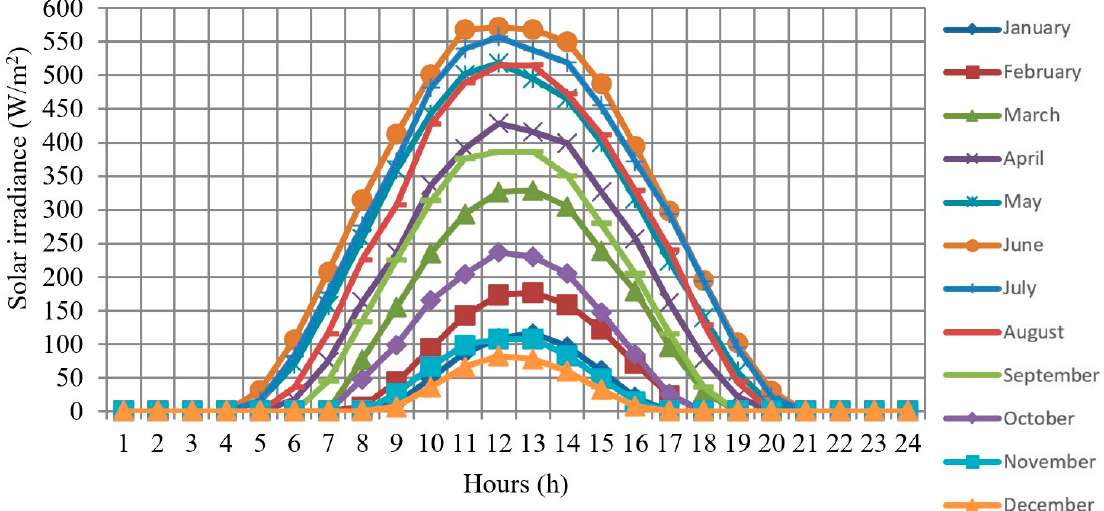
Figure 1. Distribution of average global solar irradiance for every hour on averaged days of different months of the average year in Warsaw.